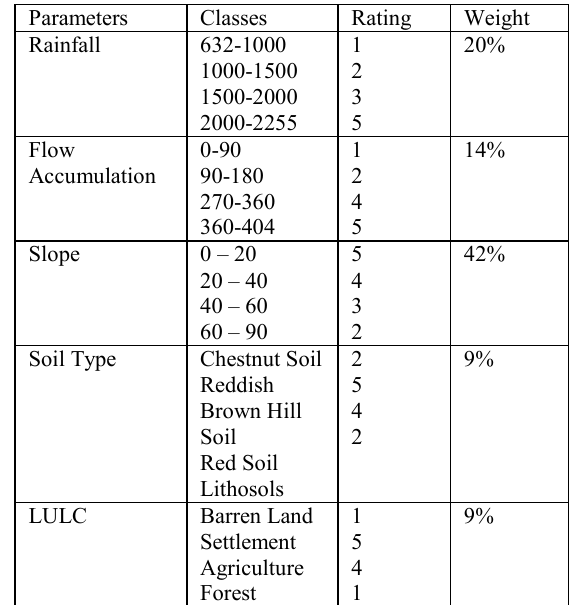
Table 10 Classes of the parameters and according weights for Flash Flood Vulnerability analysis.